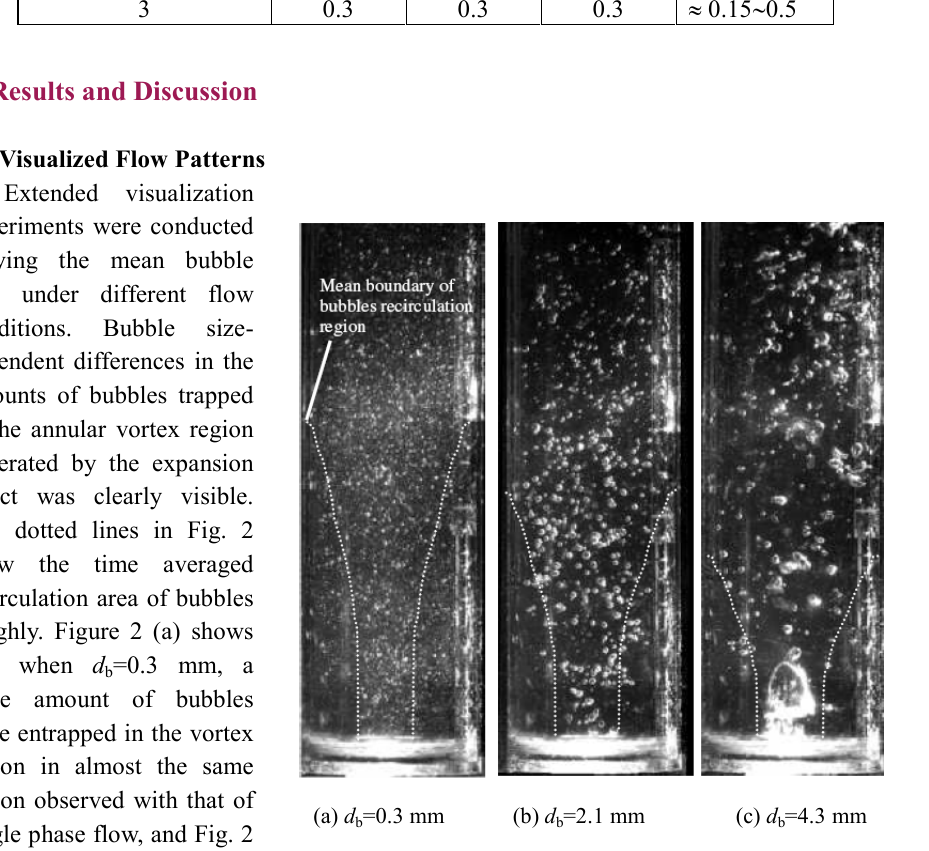
Fig.2 Visualized flow pattern for different bubble size ( Re = 1.0 × 10 4 , α v